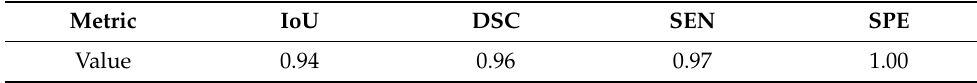
Table 1. Obtained result of lung segmentation metrics.